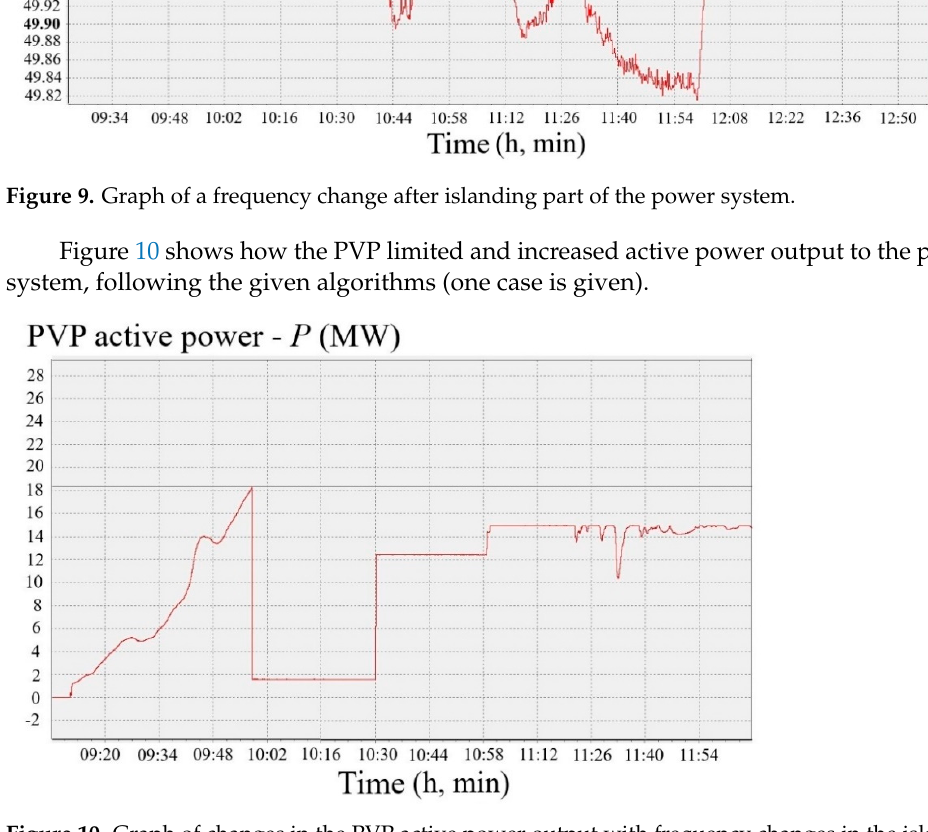
Figure 10. Graph of changes in the PVP active power output with frequency changes in the islanded part of the power system.